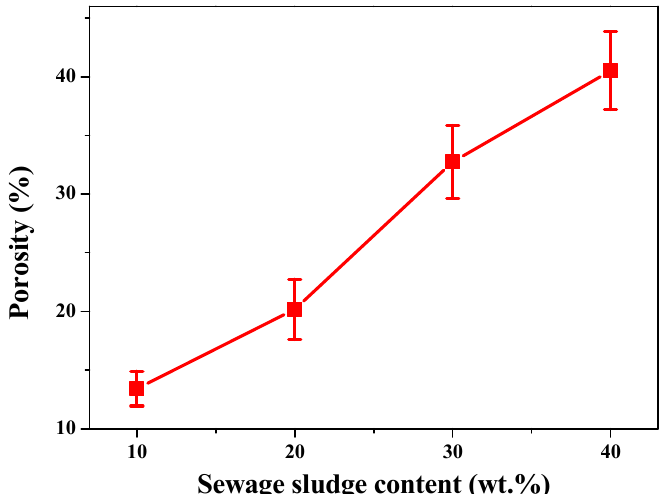
Figure 5. Sintering shrinkage rate of the ceramic bricks with various sewage sludge contents.